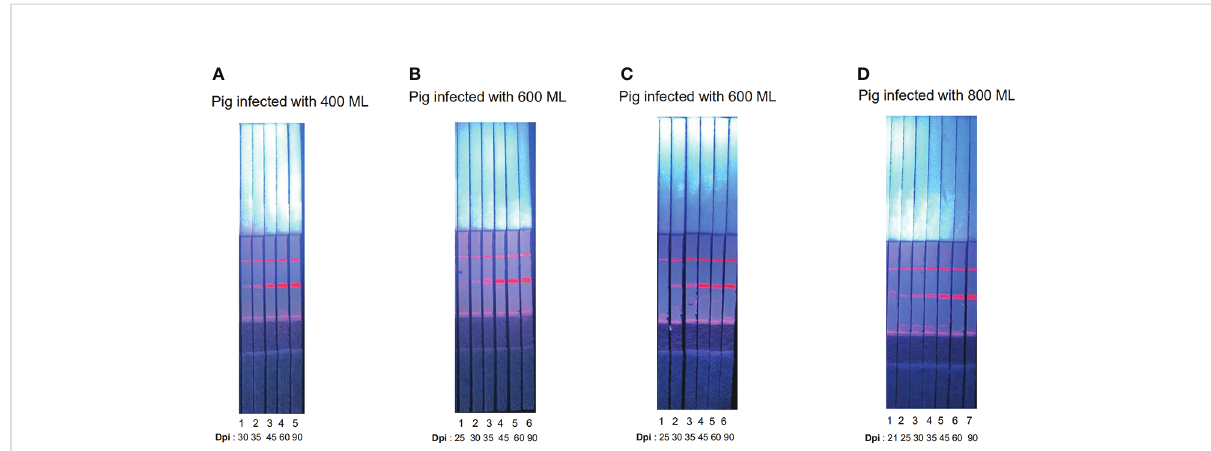
FIGURE 4 Serum samples detected by ECM-ICS. (A) Samples from pigs infected with 400 Trichinella . (B) Samples from pigs infected with 600 Trichinella . (C) Samples from pigs infected with 600 Trichinella . (D) Samples from pigs infected with 800 Trichinella . (A1 – 5) 30, 35, 45, 60, and 90 dpi; (B1 – 6) 25, 30, 35, 45, 60, and 90 dpi; (C1 – 6) 25, 30, 35, 45, 60, and 90 dpi; (D1 – 7) 21, 25, 30, 35, 45, 60, and 90 dpi.